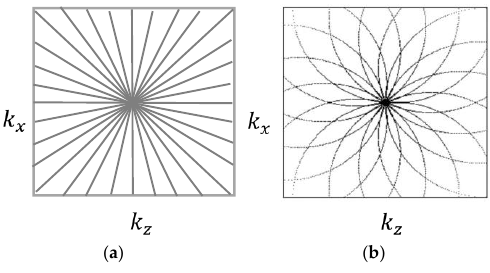
Figure 4. Difference in the Fourier space representation between the ( a ) projection and ( b ) diffraction optical tomography.